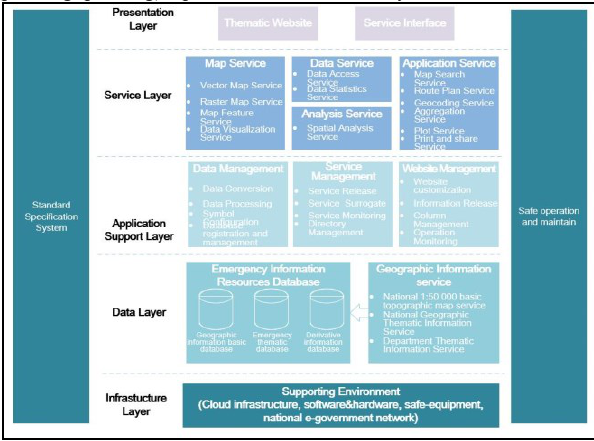
Figure 2. System structure